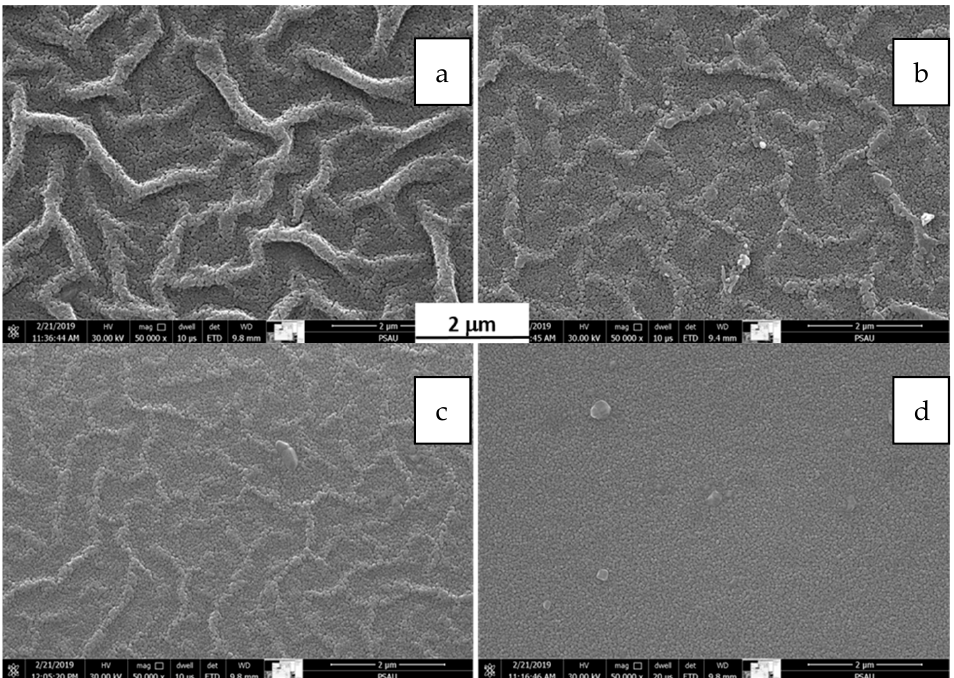
Figure 6. SEM images of ZnO films coated at different spinning speeds: ( a ) 2000 rpm, ( b ) 2500 rpm, ( c ) 3000 rpm and ( d ) 3500 rpm.